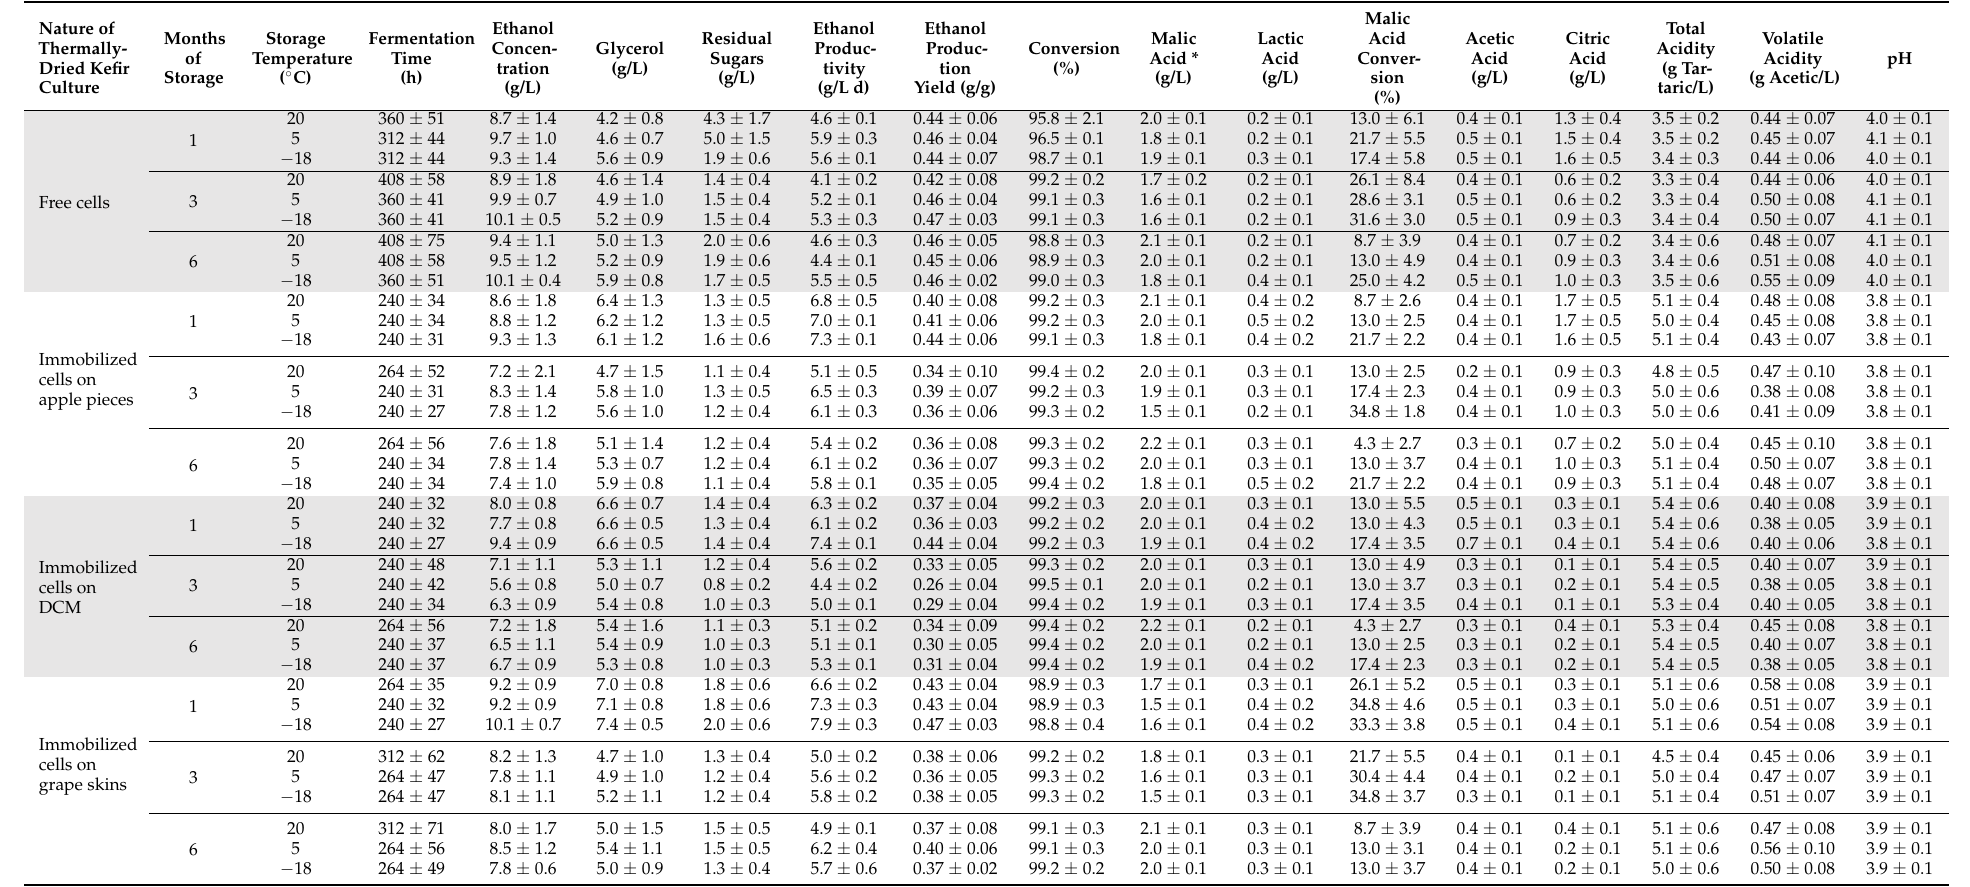
Table 3. Effect of storage on the kinetic parameters and profile of organic acids of low alcohol wines fermented at 30 ◦ C using thermally-dried free or immobilized kefir